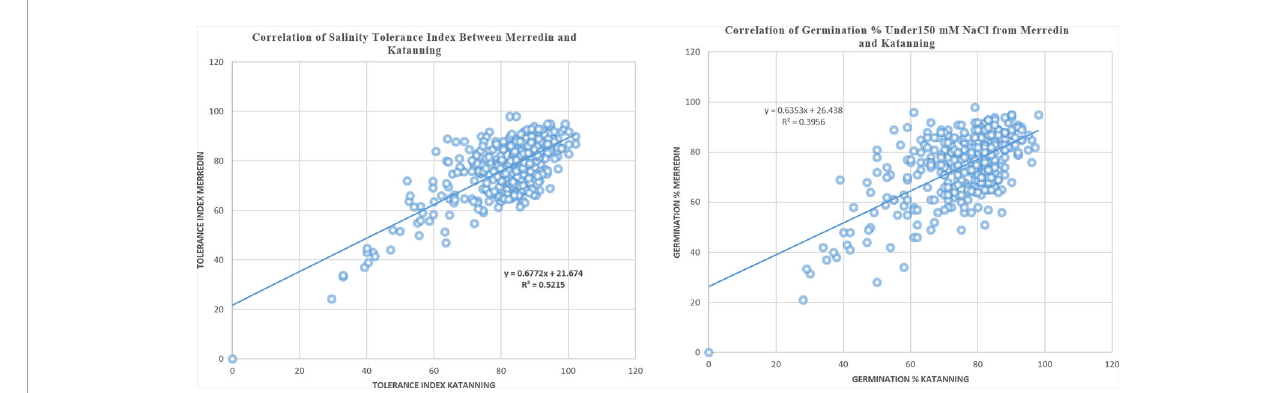
FIGURE 2 | Correlation coef fi cient for seeds sourced from Merredin and Katanning for tolerance index and germination in 150 mM